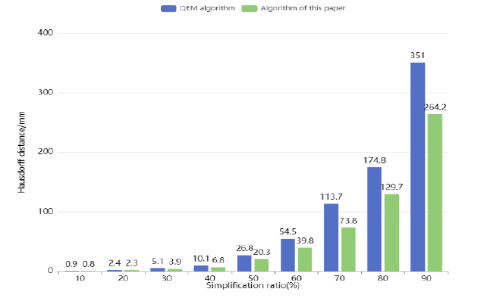
Figure 6 . Comparison of simplification errors of different methods